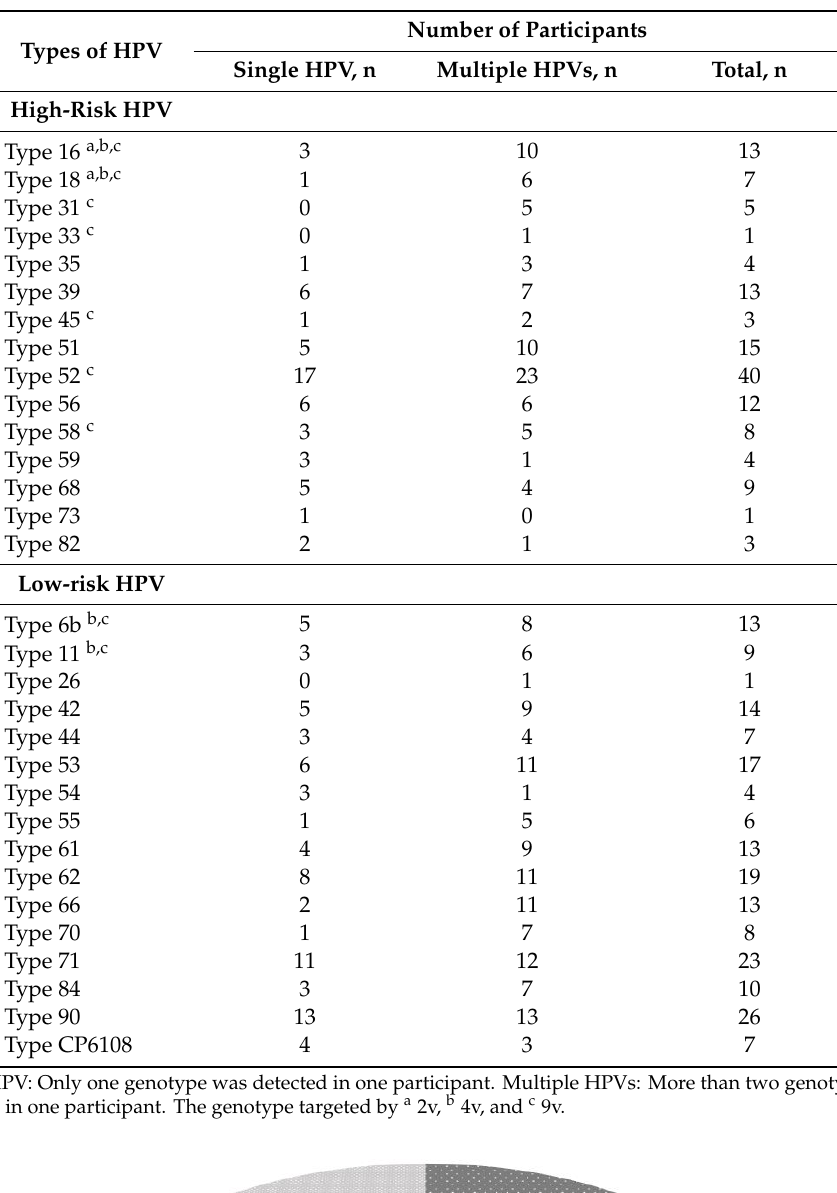
Table 2. The number of detected HPV genotypes among Japanese males.